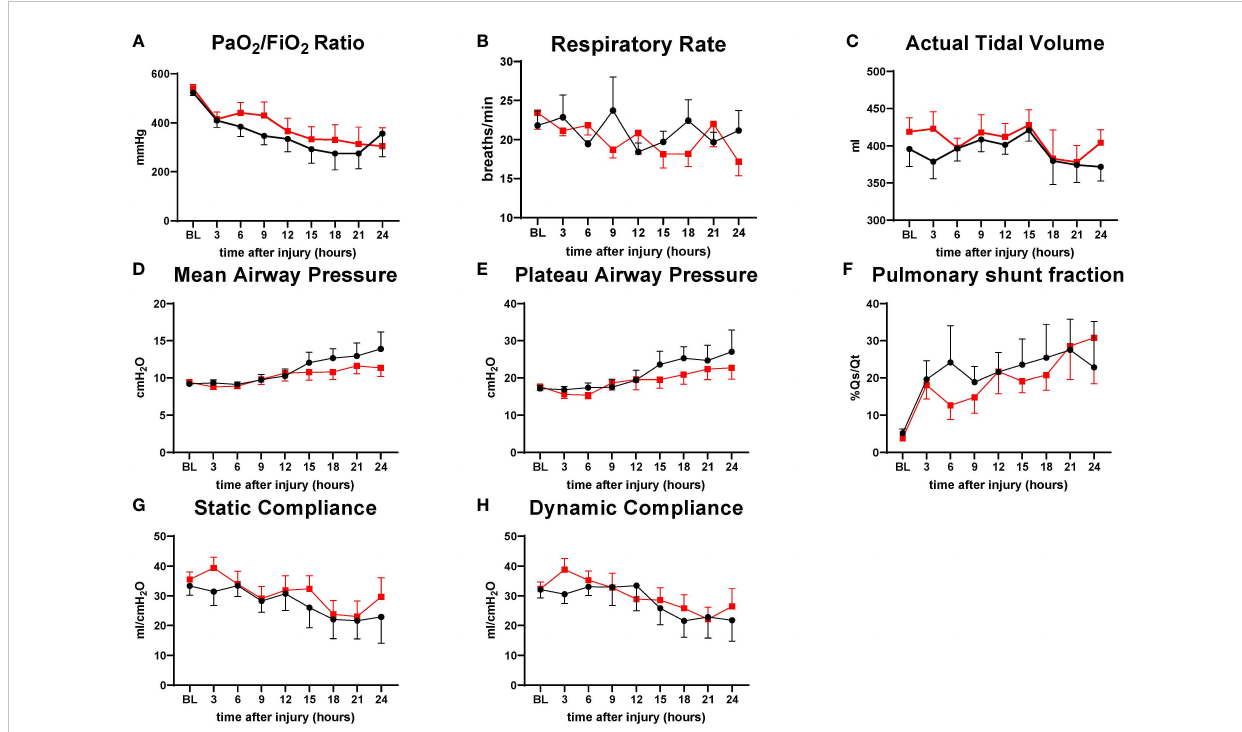
FIGURE 2 The severity of lung injury. ● Control (n=7 at 0-18 h and 6 at 19-24 h), ■ Treatment (n=7 at 0-16 h and 6 at 17-24 h. There were no differences in pulmonary function.